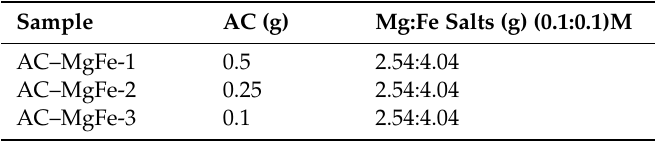
Table 6. Composition of AC–MgFe